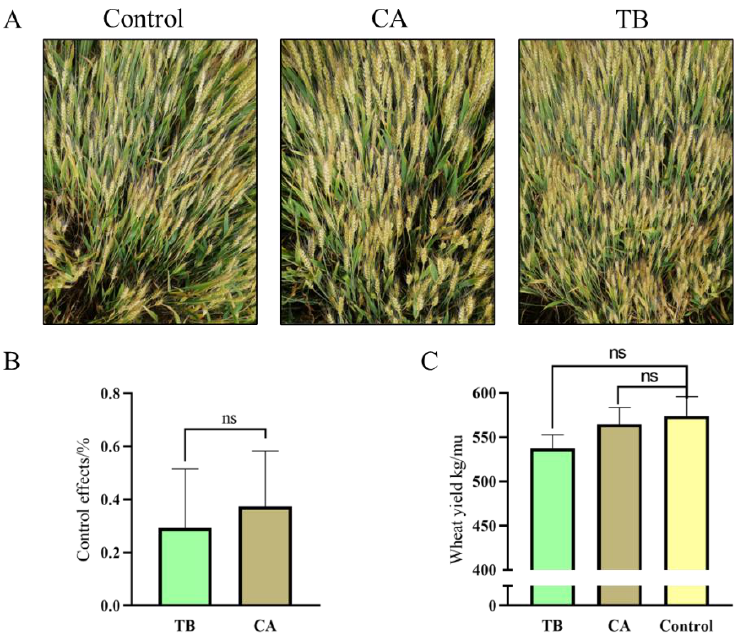
Figure 8. Effects of Trichoderma – Bacillus SCA on ( A , B ) control of wheat head blight and ( C , D ) wheat production in Xinxiang, Henan Province, China. TB denotes the seed-coating agent of T. atroviride SG3403 and B. subtilis 22 co-culture, and CA denotes the tebuconazole. The co-culture seed-coating agent of Trichoderma and Bacillus has a synergistic effect on the control of wheat head blight and can also improve wheat production. The disease control effects of T. atroviride SG3403 and B. subtilis 22 were similar to that of the chemical agent. Additionally, the impacts on production were the same. Thi s demonstrated that the TB agent can reduce the use of chemical fungicides. “ns” represents non -